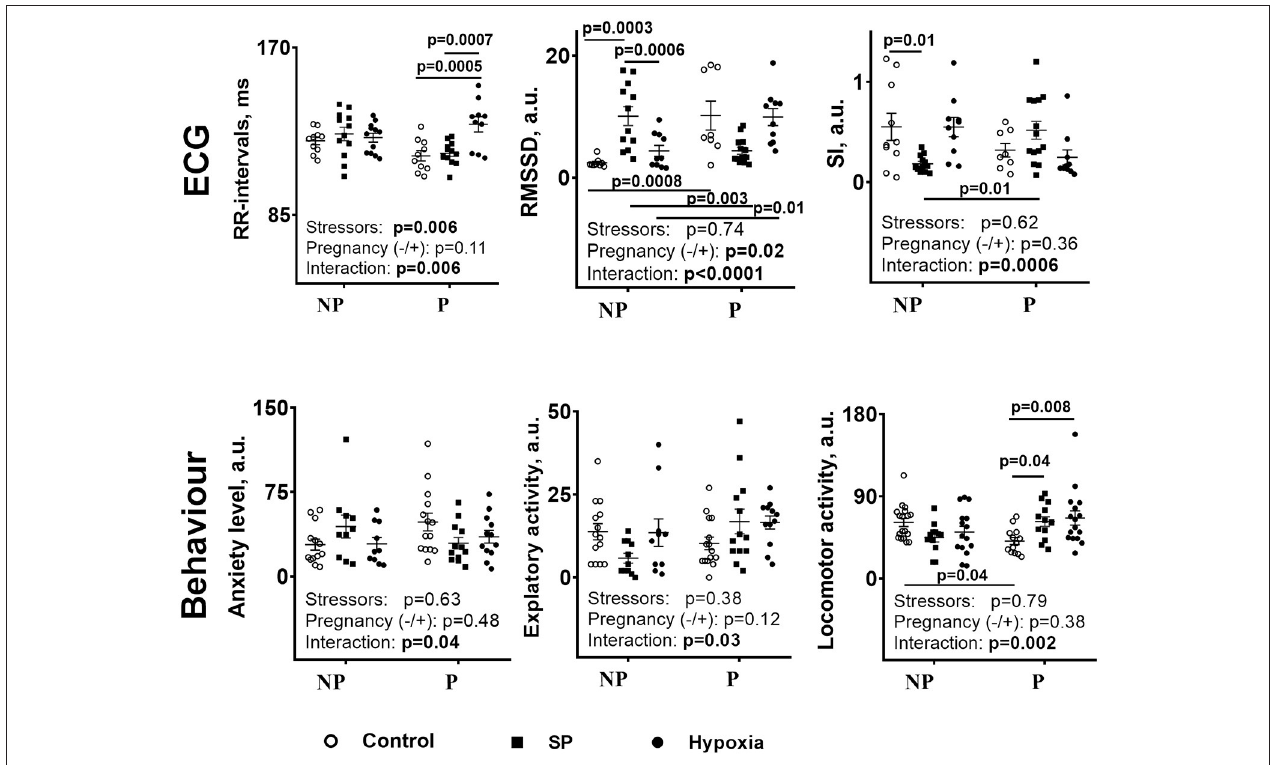
FIGURE 2 | Comparison of the influence of SP or acute hypobaric hypoxia on physiological parameters of the NP and P rats. NP—the non-pregnant rats: control n = 17, SP n = 13, hypoxia n = 12. P—pregnant rats: control n = 10, SP n = 13, and hypoxia n = 10. Statistical analysis by two-way ANOVA is described in Methods. Both the post-hoc -test-determined statistically significant differences between the groups and ANOVA-determined significance of the factors (stressors SP or hypoxia and pregnancy) and their interaction are given on the